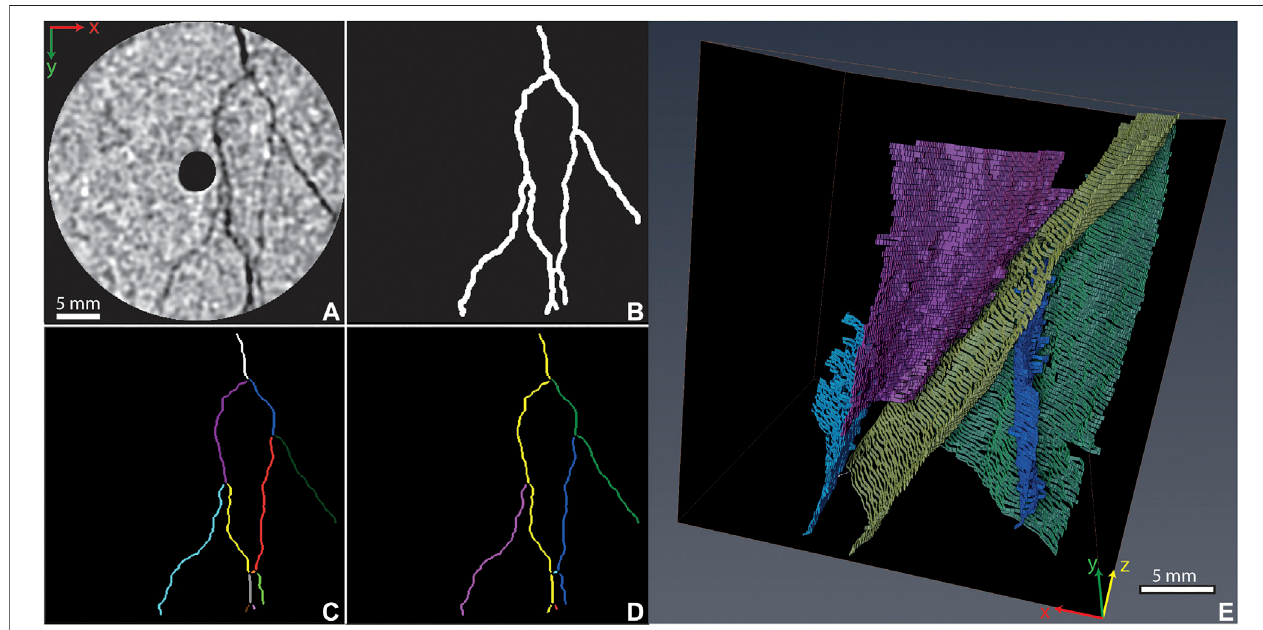
FIGURE6| 2Dsliceofthegranitesample (A) andtherelatedbinaryimageofthefracturesusedintheanalysis (B) .Thebinaryimagewasskeletonizedandanalyzed in order to disassemble the fracture system into segments (C) then these segments were re-connected when they were recognized to lie on the same fracture plane based on criteria described in Fracture Separation Analysis (D,E) . The skeleton of the segments (C,D) has a theoretical width of 1 pixel; however, for visualization purposes, their width was slightly increased.